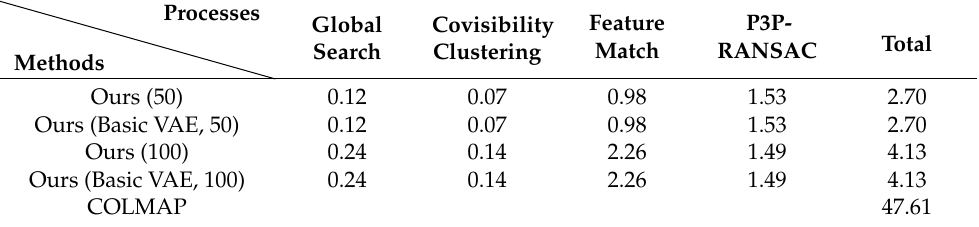
Figure 10. Image retrieval results from the Baidu data set. The first column includes the query images, followed by the top five retrieved images. Table 3. Comparison of running time in second. Ours (50) means retrieval of 50 images in prior image retrieval stage, and Ours (100) means retrieval of 100. Record of the running time of the entire localization of COLMAP and running time in different stages of our methods.